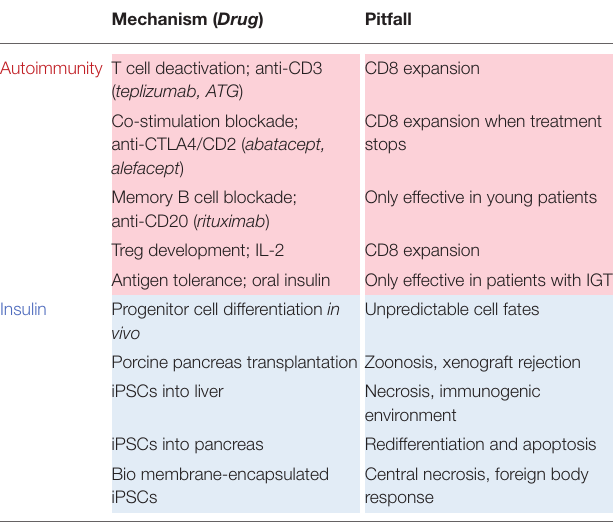
TABLE 1 | Treatment strategies and pitfalls. Mechanism ( Drug )